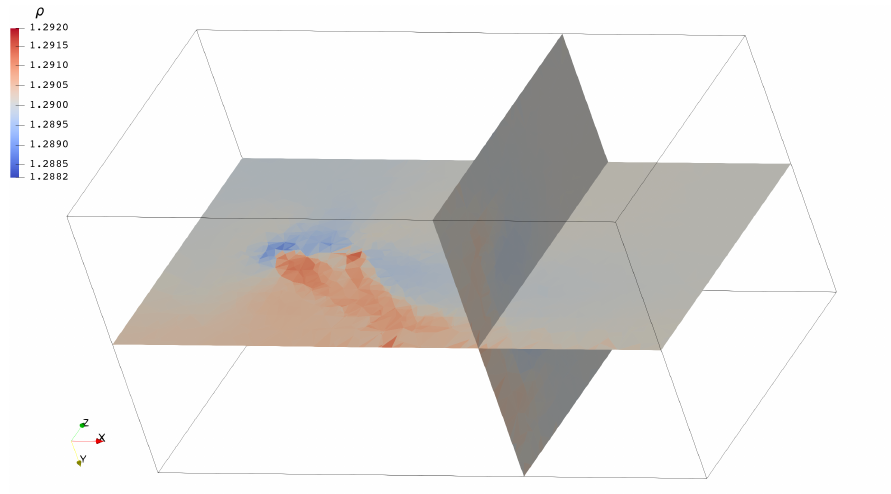
Figure 34. Third-order solution of Problem 8 at t = 1.